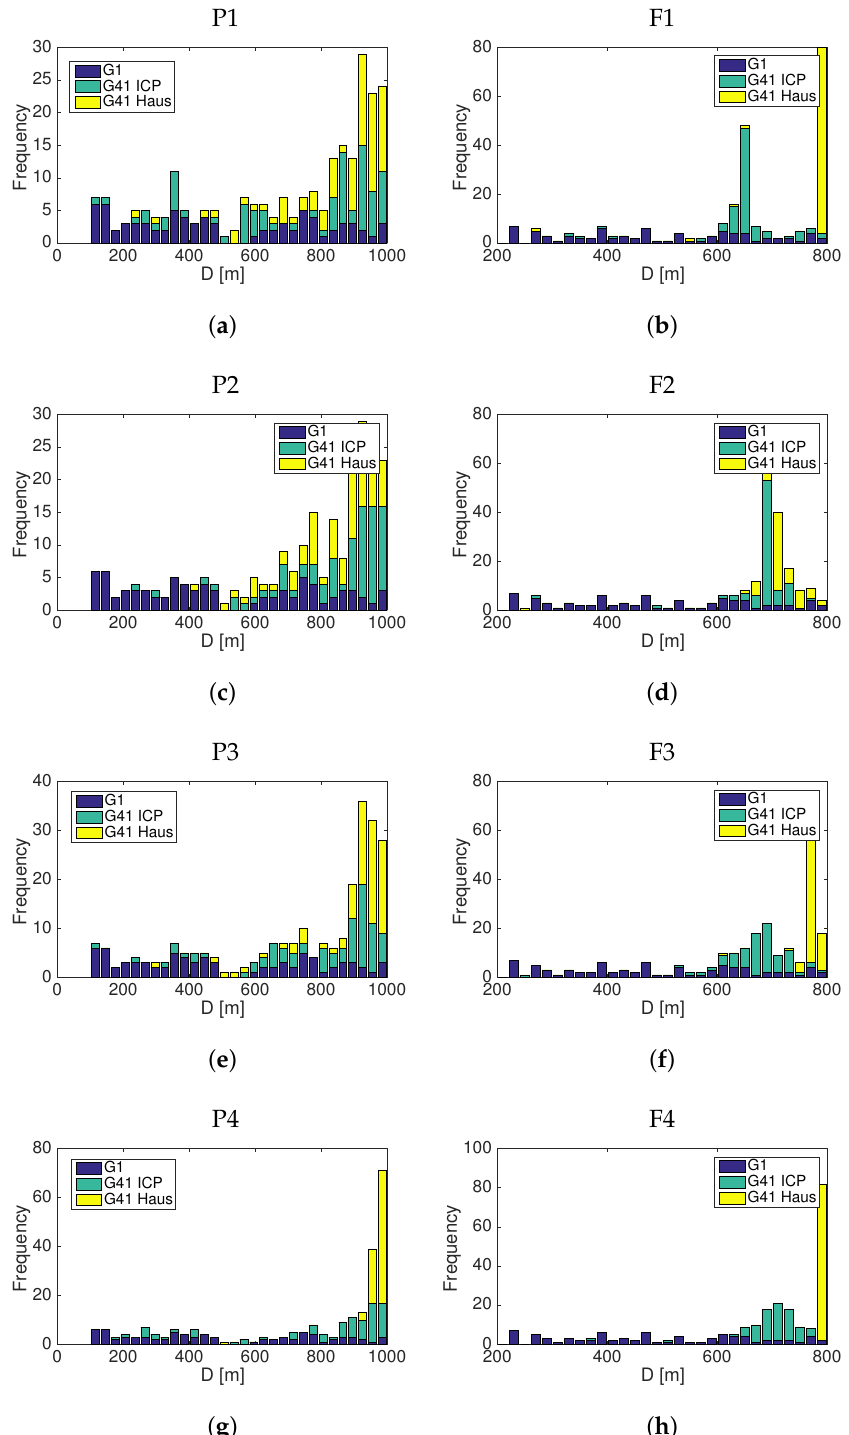
Figure 8. Histogram of the optimized distances between landmarks found by the genetic algorithm after 41 iterations (G41) compared to the initial distribution of distance genes (G1) for the primitive shapes P1, P2, P3, P4 ( a , c , e , g ), and the free piecewise linear shapes F1, F2, F3, F4 ( b , d , f , h